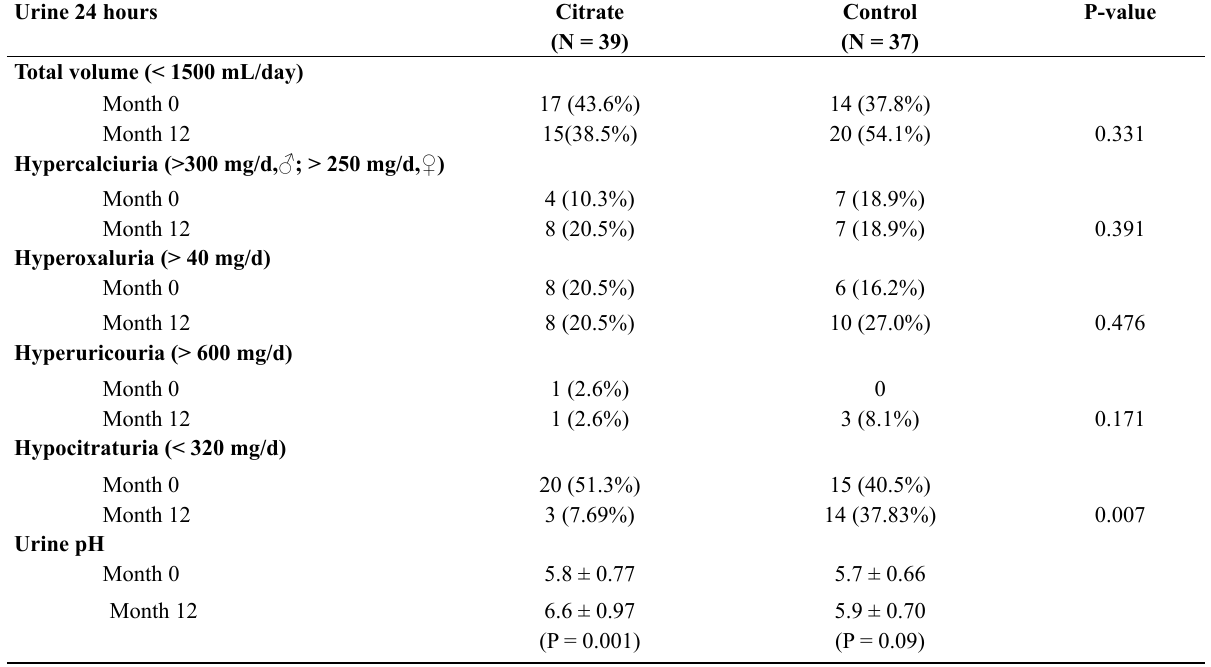
Table 2 - 24 hours urine metabolic evaluation.